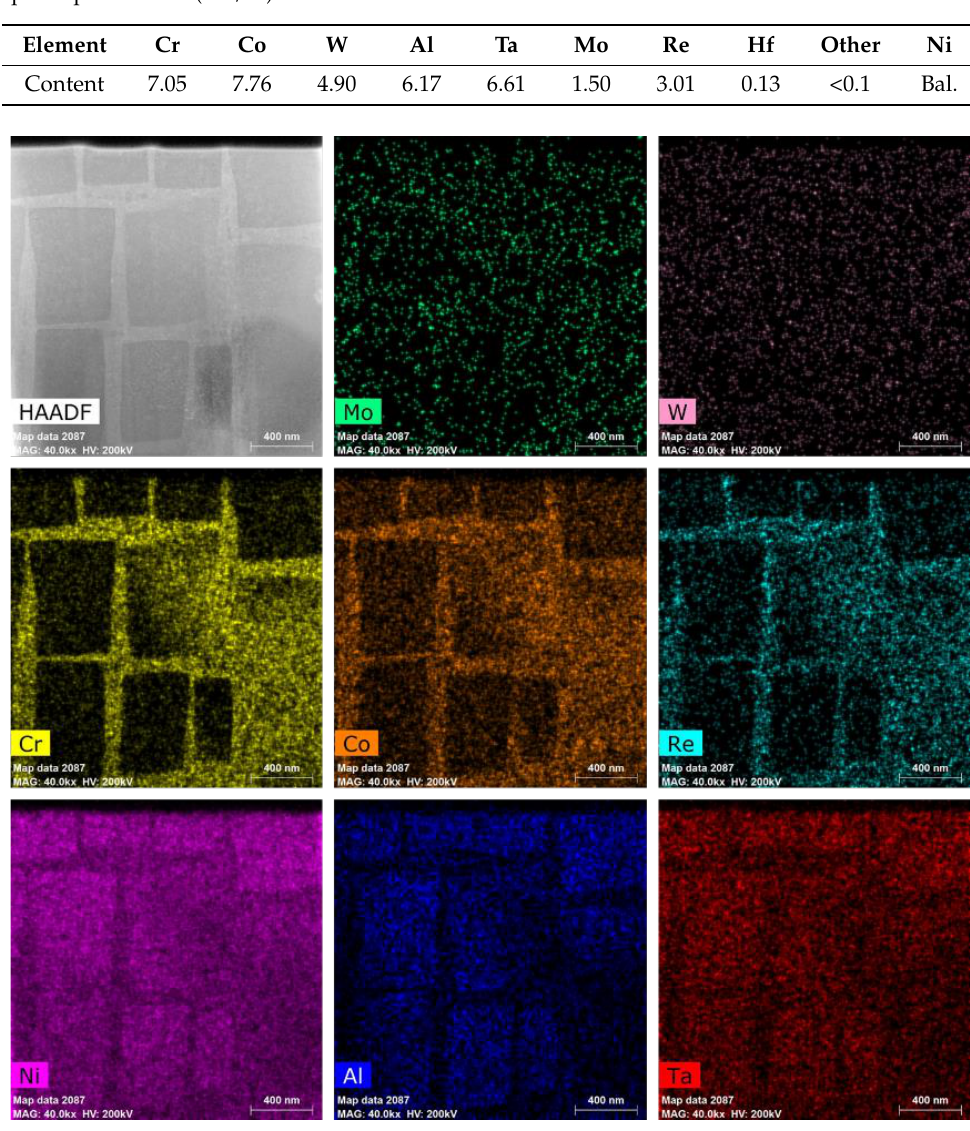
Figure 1. HADDF-EDS mapping of the single-crystal Ni-based superalloy.